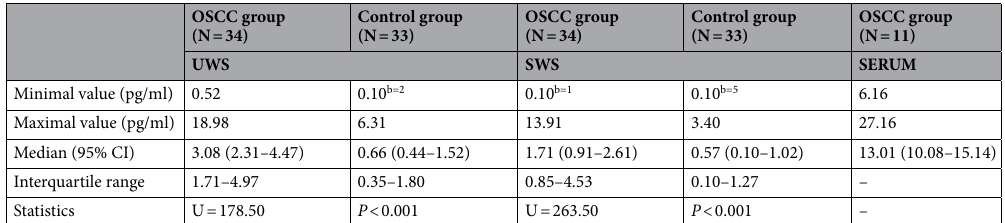
Table 2. Melatonin levels comparison in unstimulated and stimulated whole saliva between the groups and descriptive statistics for melatonin serum values in oral squamous cell carcinoma patients. a OSCC oral squamous cell carcinoma, CI confidence interval, UWS unstimulated whole saliva, SWS stimulated whole saliva. b Number of values below the limit of detection.